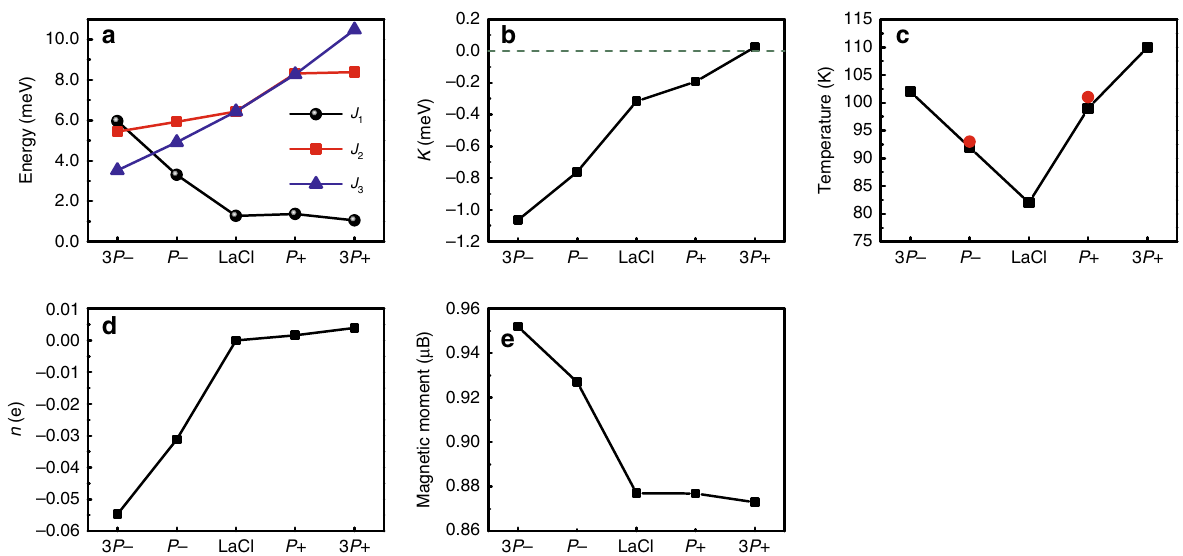
Fig. 4 The in fl uence of polarization intensity on magnetic parameters. a Exchange interaction parameters in LaCl. b Perpendicular magnetic anisotropy constant in LaCl ( c ) Curie temperature ( T c ) of LaCl. Since we only calculated the DMI of LaCl/ P ± , the effects of the perpendicular magnetic anisotropy and exchange interaction terms on T c are presented by the data in black squares, and the effect of DMI on T c in LaCl/ P ± is presented by the data in red spheres. d The number of electrons gained of LaCl. e The net magnetic moment of LaCl. In these fi gures, 3 P ± represents a con fi guration that contains three In 2 Se 3 layers.